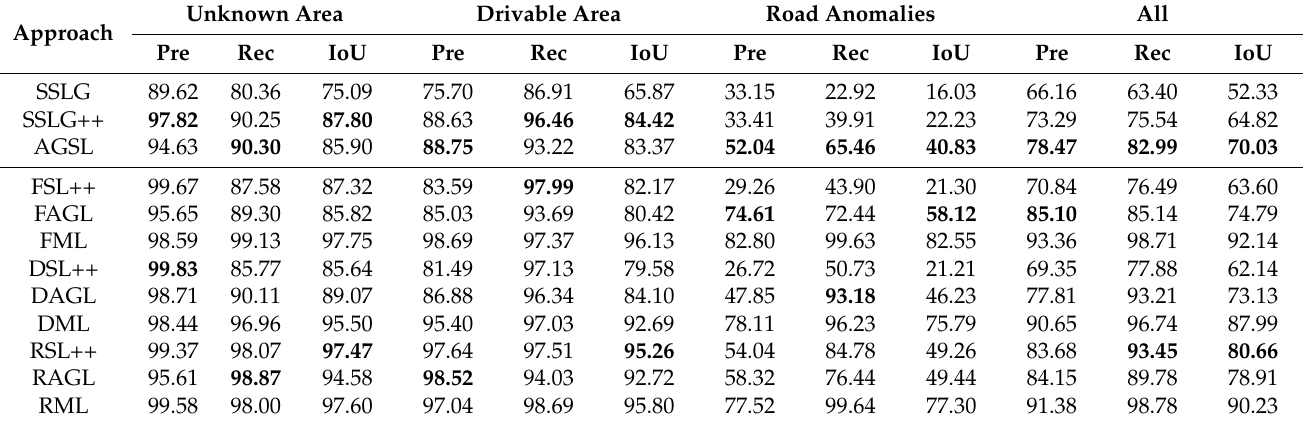
and RTFNet trained on manual label (RML). Best results without using manual labels are highlighted in bold